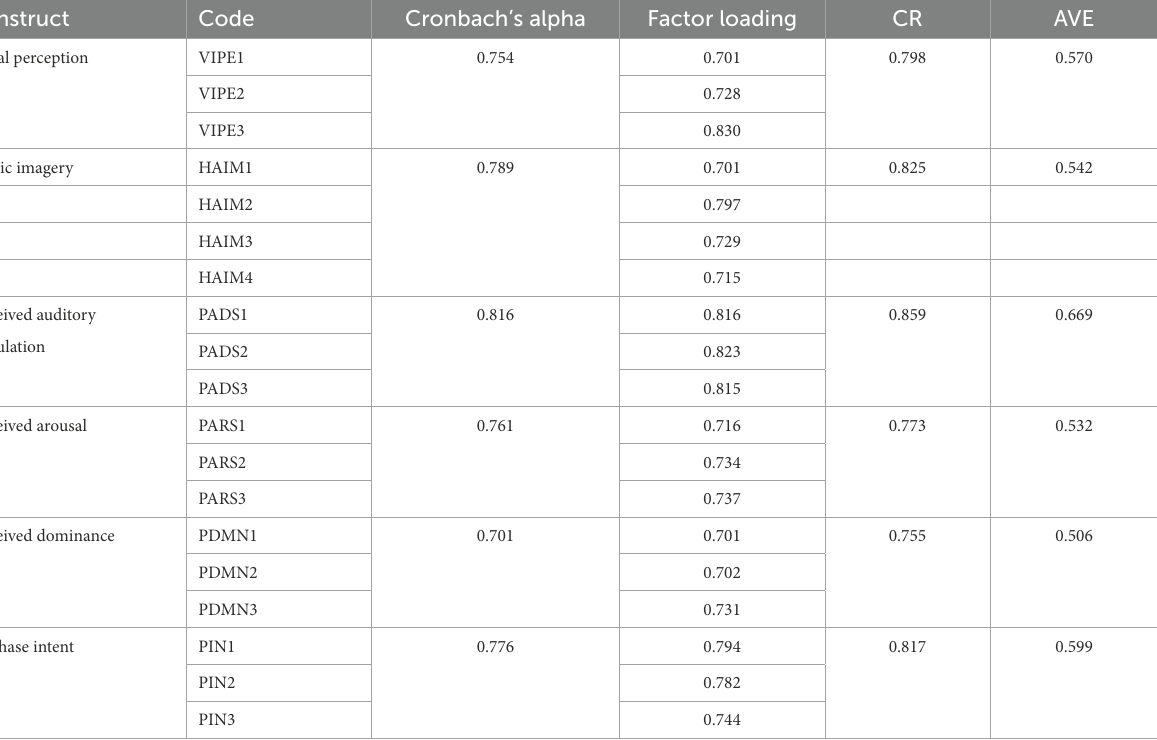
TABLE 4 Exploratory factor analysis.